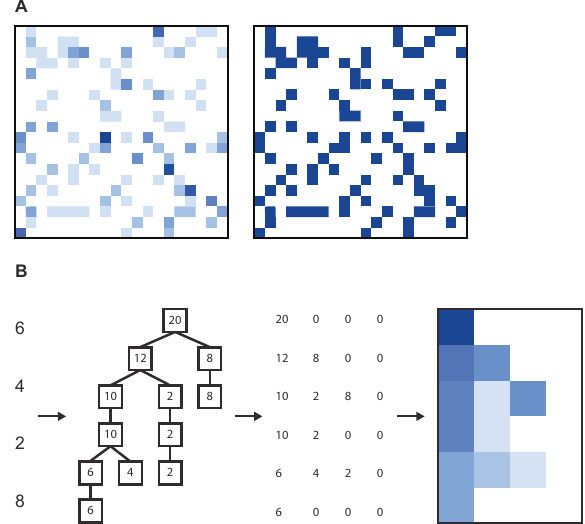
Fig. 1 Examples of CNN image inputs generated from OTU tables. A The image is fi lled with species abundances (left) or presences (right). B For a single sample, the phylogenetic tree is constructed, populated with species abundances, and rearranged into a